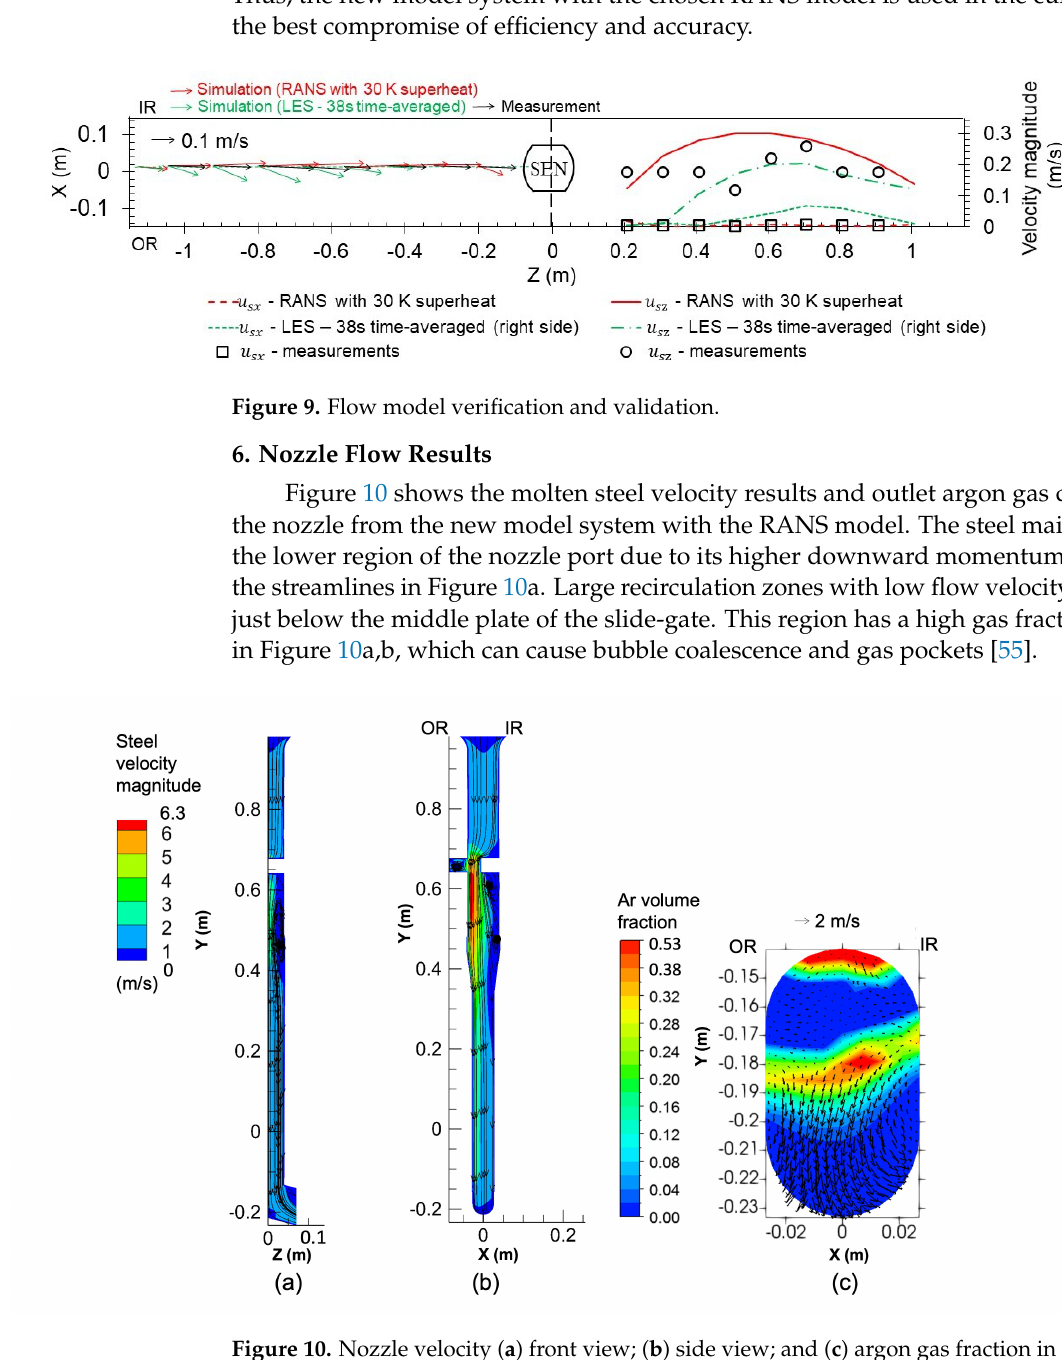
Figure 10. Nozzle velocity ( a ) front view; ( b ) side view; and ( c ) argon gas fraction in the plane of the outlet